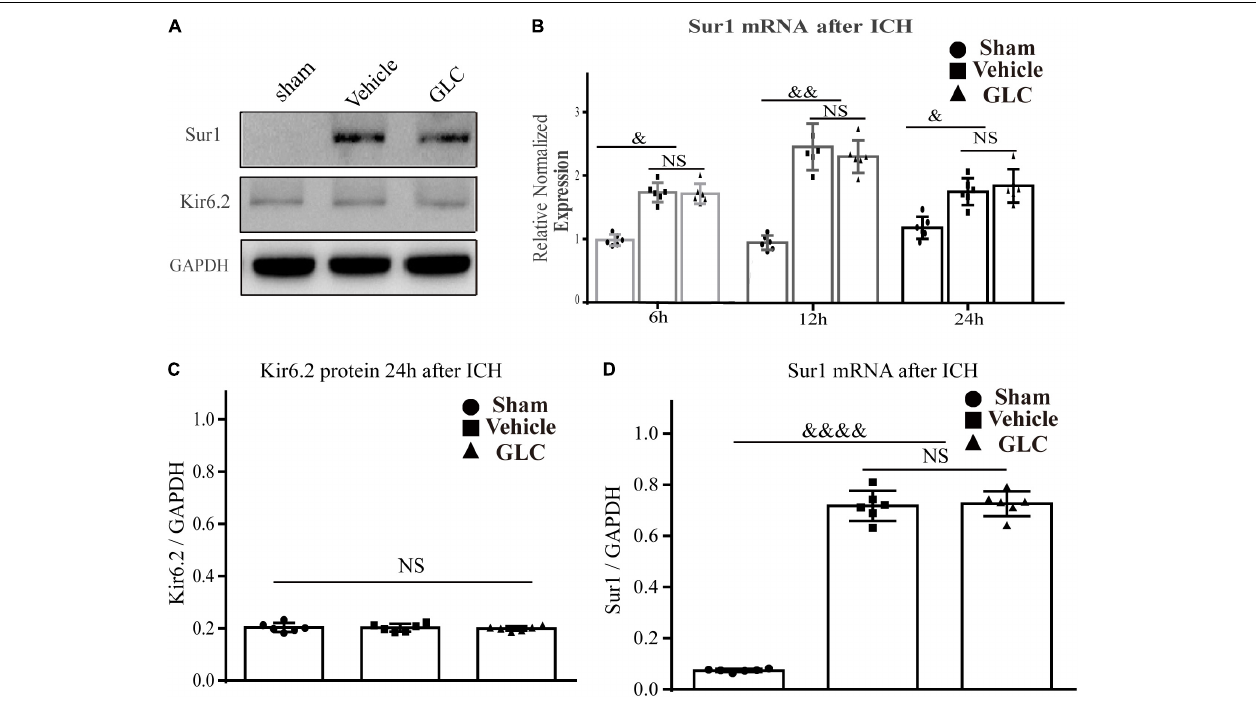
FIGURE 1 | Sulfonylurea receptor 1 (Sur1), but not Kir6.2, is upregulated in the aged rat model of intracerebral hemorrhage (ICH). (A,C,D) Western blot analysis and quantification of the mean density of the Sur1 (180 kDa) and Kir6.2 (45 kDa) bands surrounding the hematoma 24 h after ICH (six rats/group). The results of the mean band densities are presented as the mean ± SD, &&&& p < 0.0001. (B) Relative normalized expression levels of Sur1 mRNA surrounding the hematoma at 6, 12, and 24 h after ICH, Sur1 mRNA expression increased and peaked at 12 h (six rats/group). The results are presented as the mean ± SD, & p < 0.05, && p < 0.01.